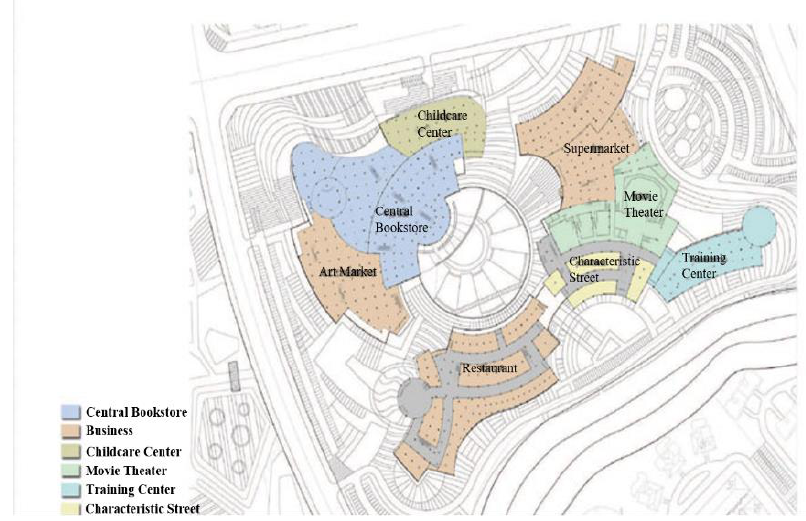
Figure 5. Layout and function of CSP.